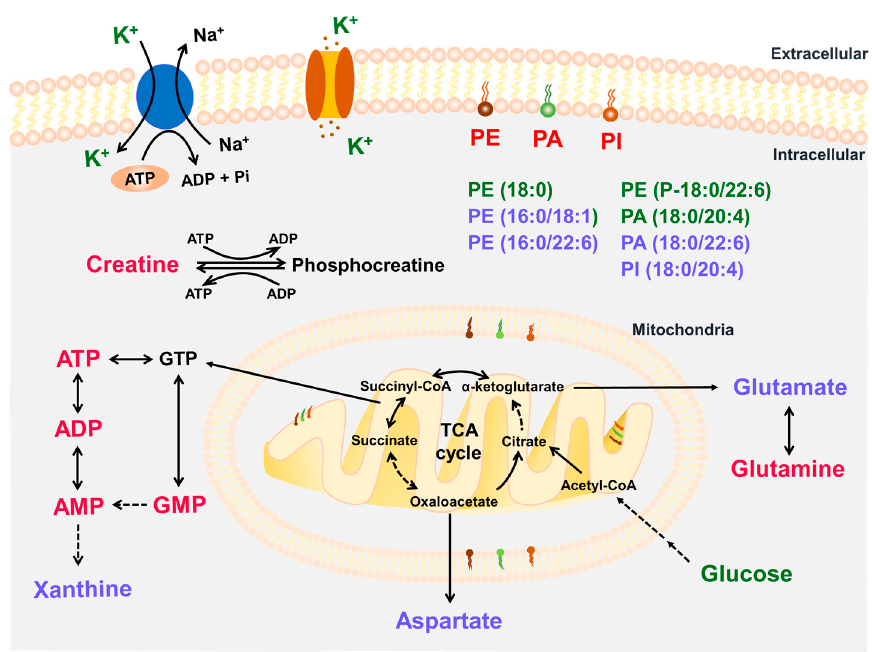
Figure 9. Summary of associations amongst the anomalous small molecules in this study. Small molecules that were significantly increased after treatment with RAE or FTA are represented in red type, and those that were significantly decreased are represented in green type. Those that were obviously altered only in the MOD group are represented in lilac type. Black arrows indicate metabolic processes; dashed arrows indicate the omission of intermediate